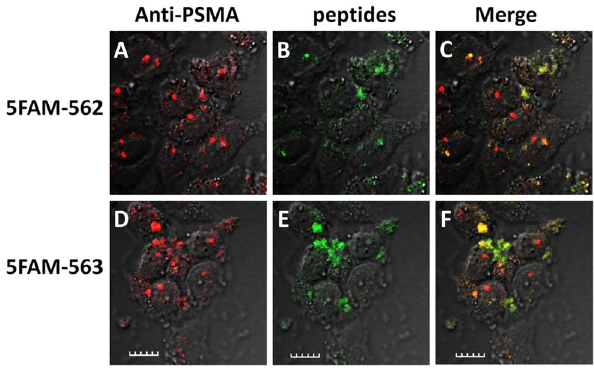
Figure 4. Binding and internalization of 5FAM-562 and 5FAM- 563 in LNCaP cells. 5FAM-562 (1 m M, A–C , green) and 5FAM-563 (1 m M , D–F , green) bound and internalized in LNCaP cells and co- localized with PSMA in intracellular vesicles visualized with anti-PSMA- Mab (red, scale is 20 m